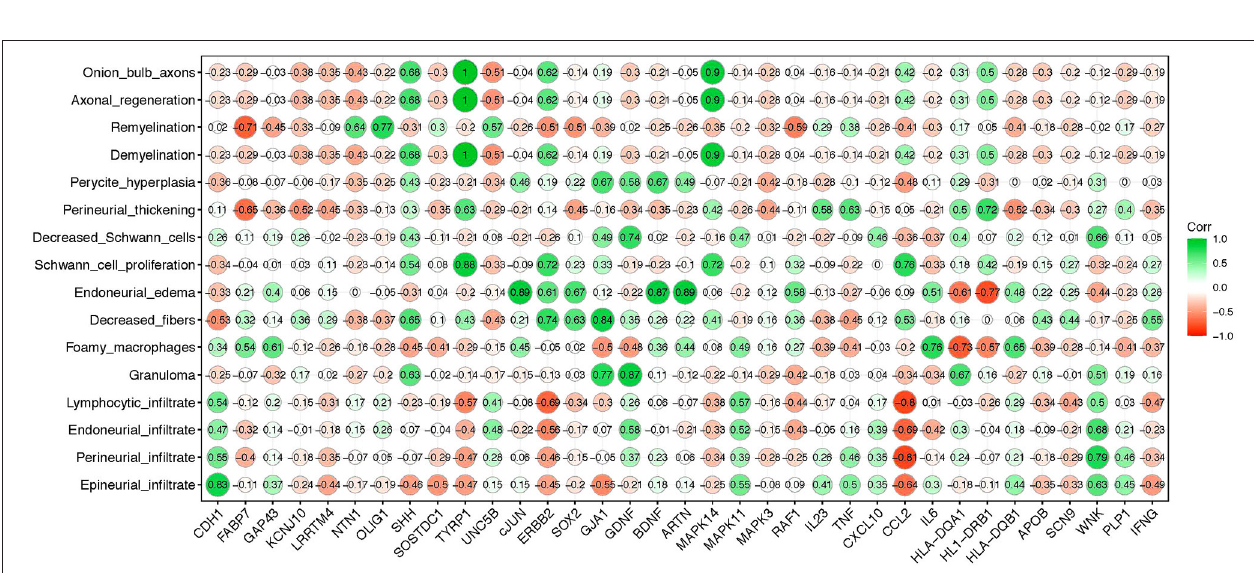
FIGURE 4 | Differentially pattern of cytokine/chemokine release after viable and dead M. leprae infection in human Schwann cells. Two-side sandwich ELISA showing the pattern secretion of pro- and anti-inflammatory cytokines and chemokines, in human Schwann cells control (gray bars) and after infection with dead M. leprae (white bars) and viable M. leprae (black bars), at 24h after stimuli in vitro , results are shown as mean ± SD from three to eight normalized independent biological replicates; * p < 0.05, ** p < 0.01, *** p < 0.001, **** p < 0.0001.